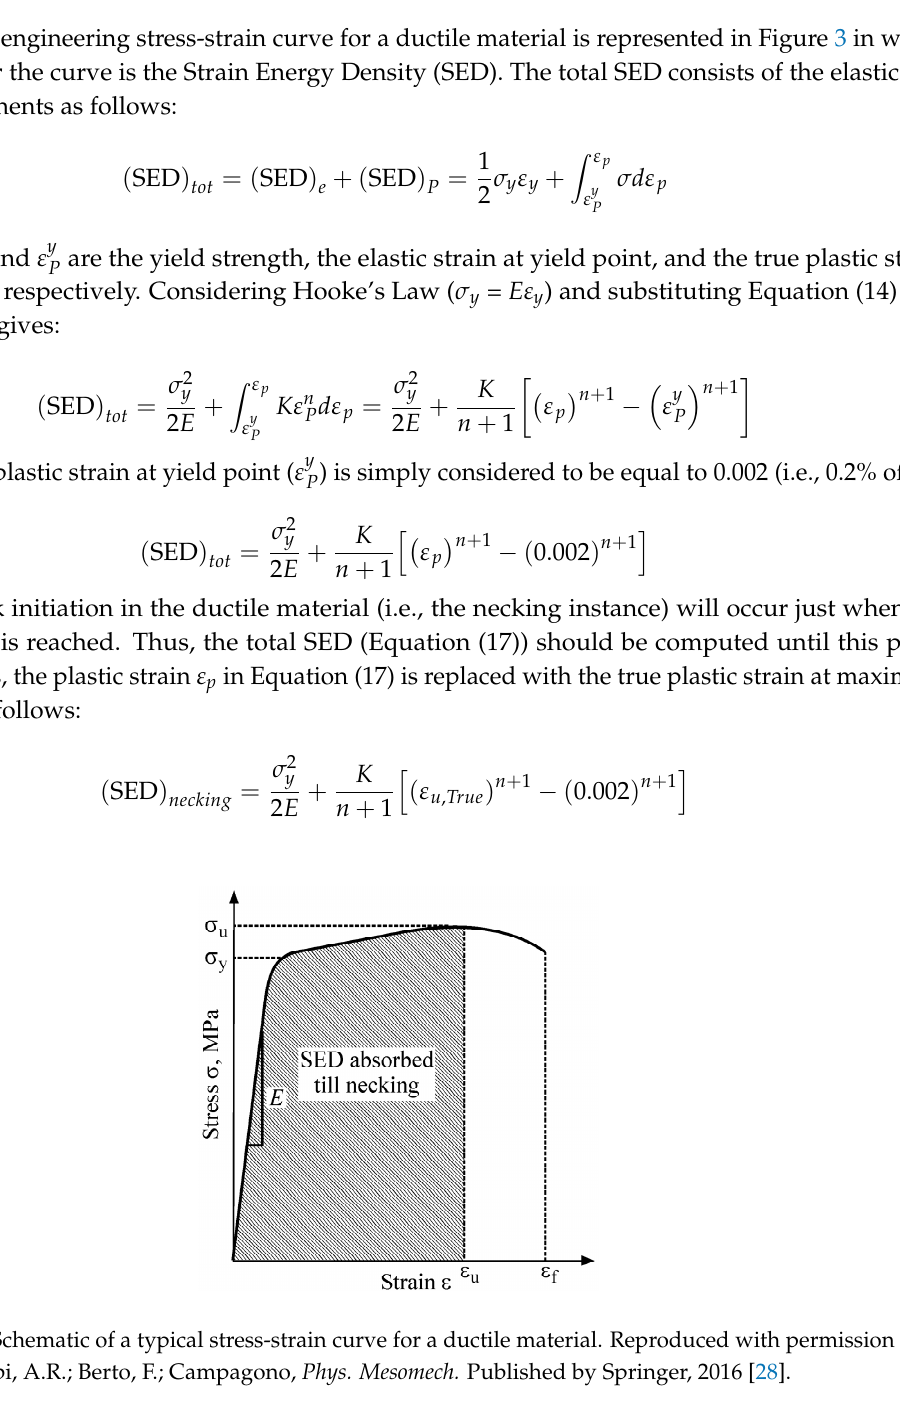
Figure 4. Schematic of the stress-strain curve for the equivalent brittle material. Reproduced with permission from Torabi, A.R.; Berto, F.; Campagono, Phys. Mesomech. Published by Springer, 2016 [28].